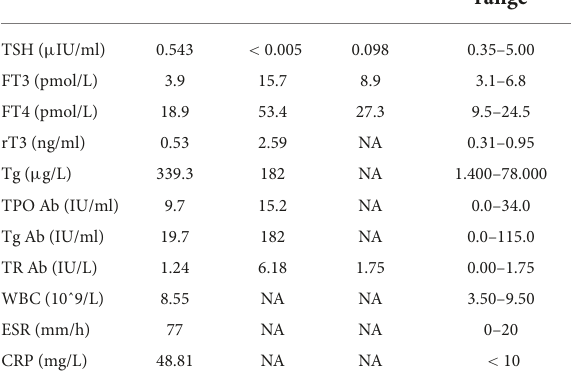
TSH,thyroidstimulatinghormone;FT3,freetriiodothyronine;FT4,freethyroxine;rT3, reverse triiodothyronine; Tg, thyroglobulin; TPO Ab, thyroperoxidase antibody; Tg Ab, thyroglobulin antibody; TR Ab, thyrotropin receptor antibody, WBC, white cell blood